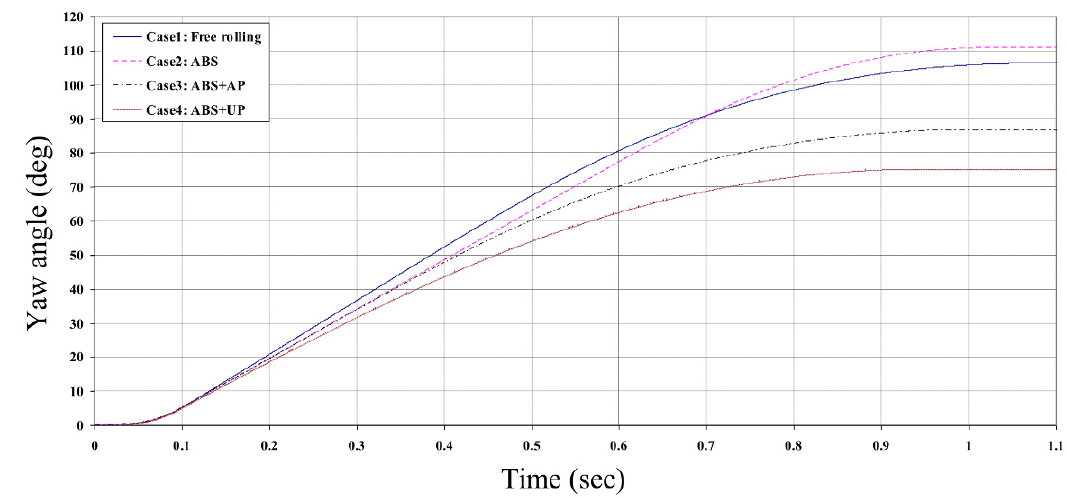
Figure 22. Yaw angle of the vehicle body for all cases at offset collision and speed of 70 km/hr.